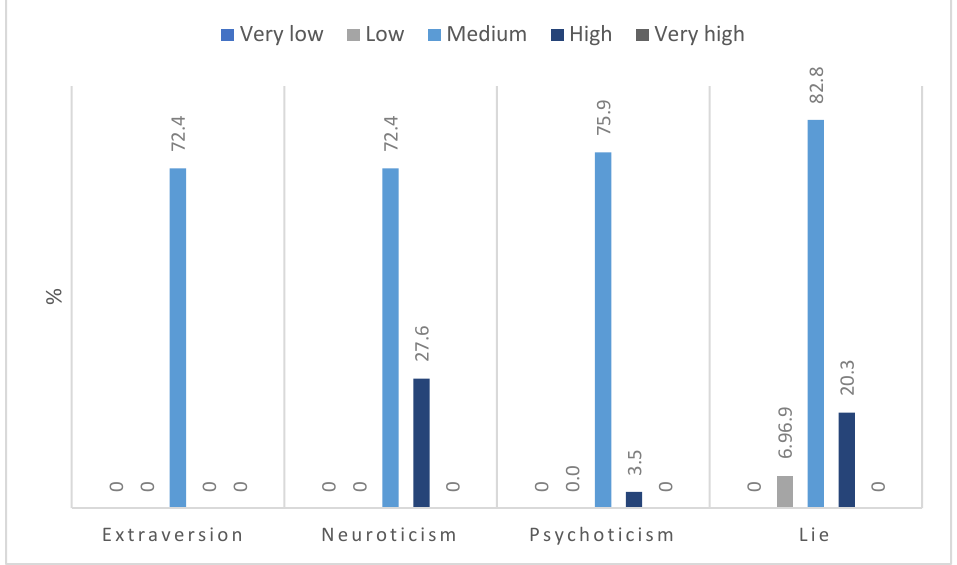
Figure 2. Intensity of personality traits.